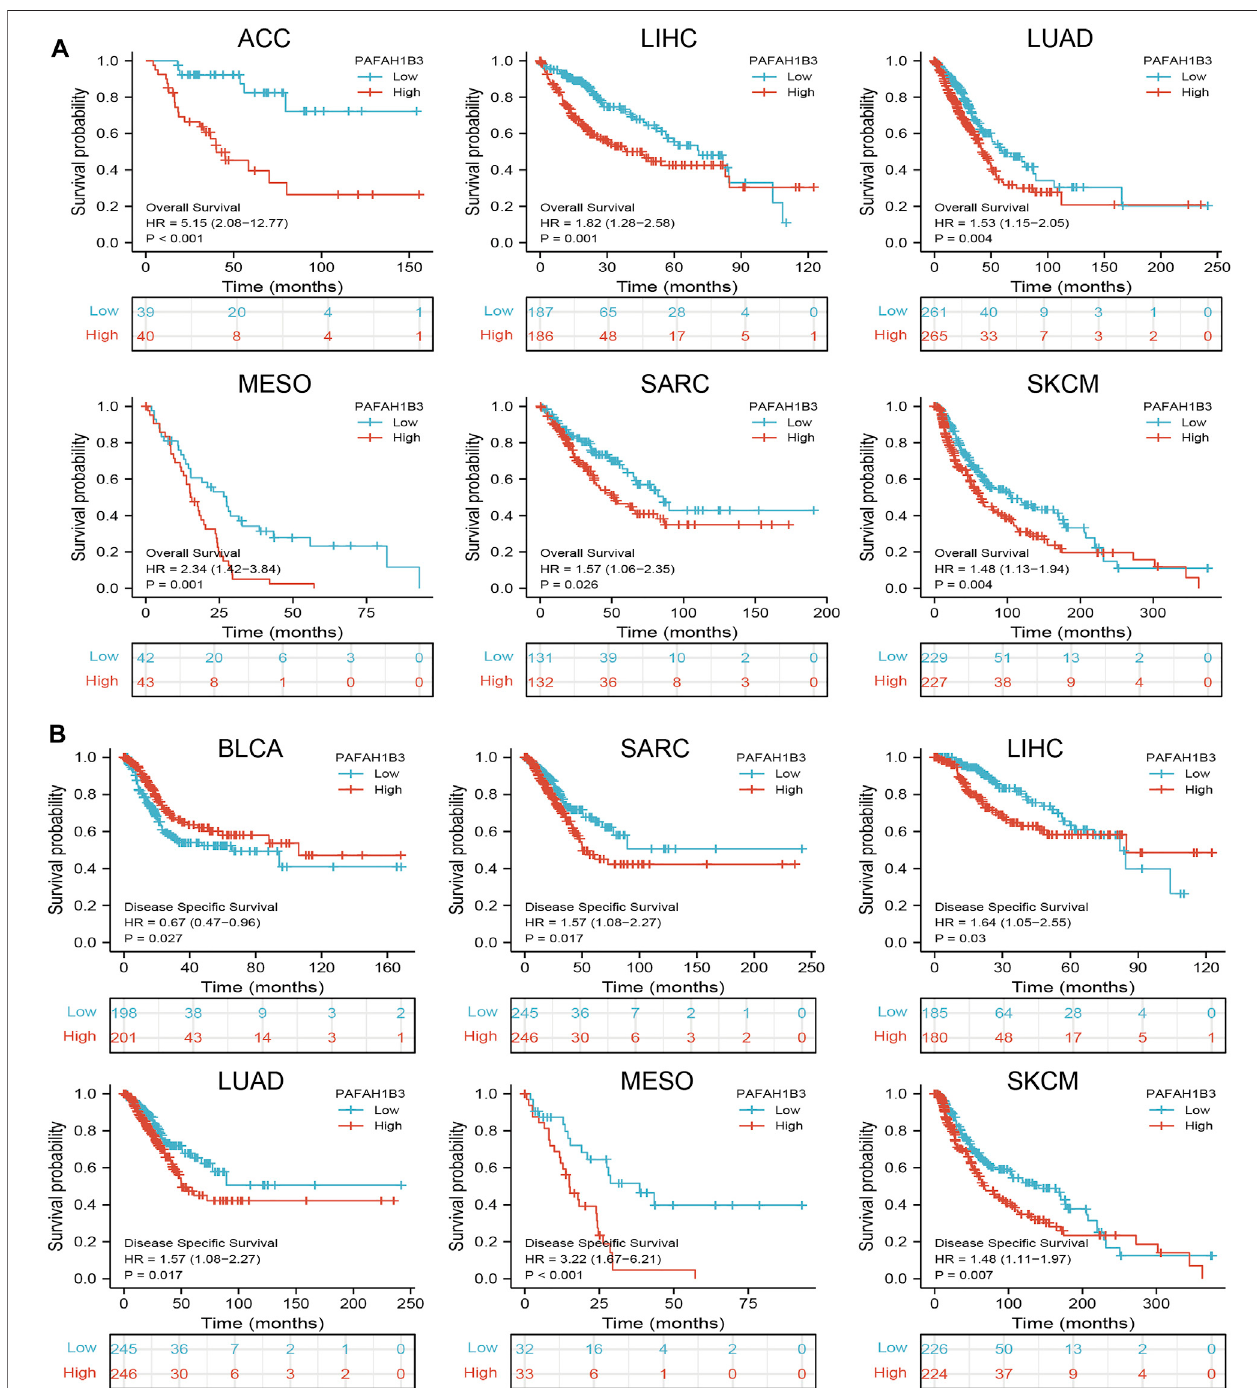
FIGURE2| AnalysisoftheprognosisvaluesforPAFAH1B3inhumancancers. (A) TheOSofPAFAH1B3indiversecancerswasexaminedbytheTCGAdatabase. (B) The DSS for PAFAH1B3 in pan-cancer examine by TCGA database.